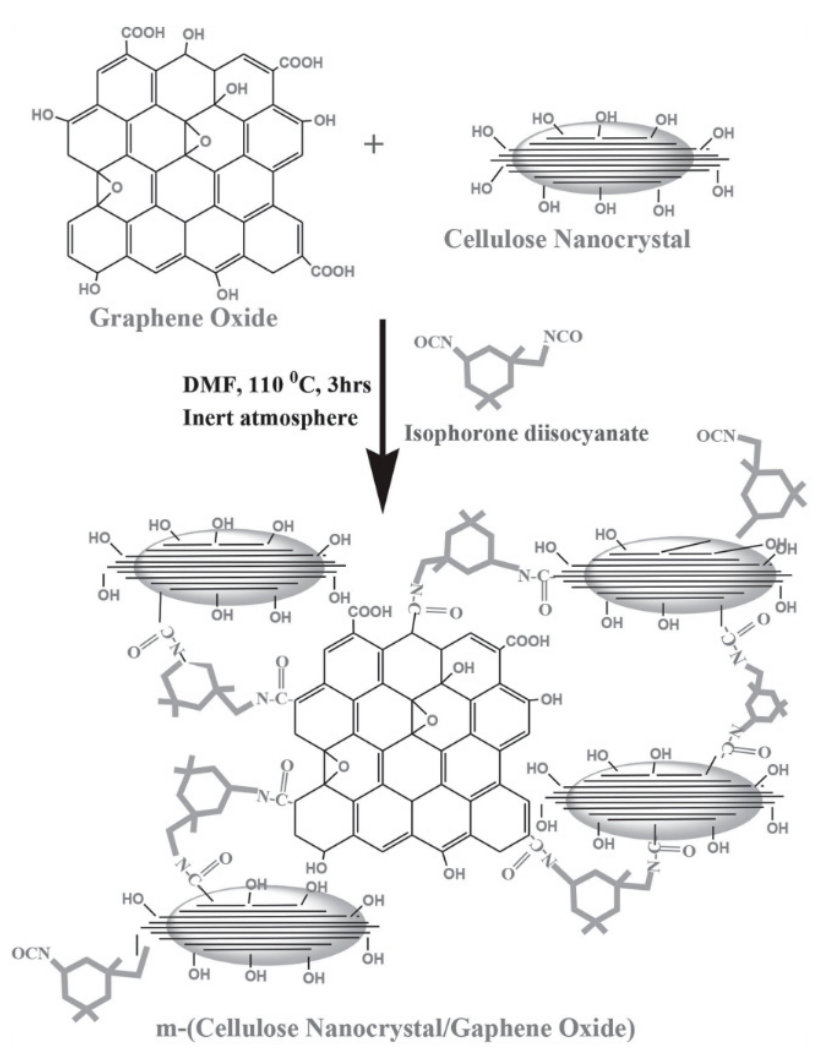
Figure 15. Reaction mechanism involved in modified CNC / GO synthesis. Reproduced with permission from Reference [181]. Copyright © 2015, Elsevier.